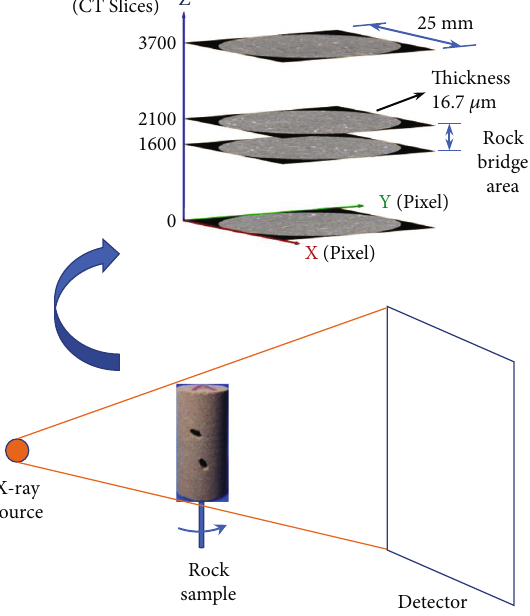
Figure 3: Sample placement and CT scanning